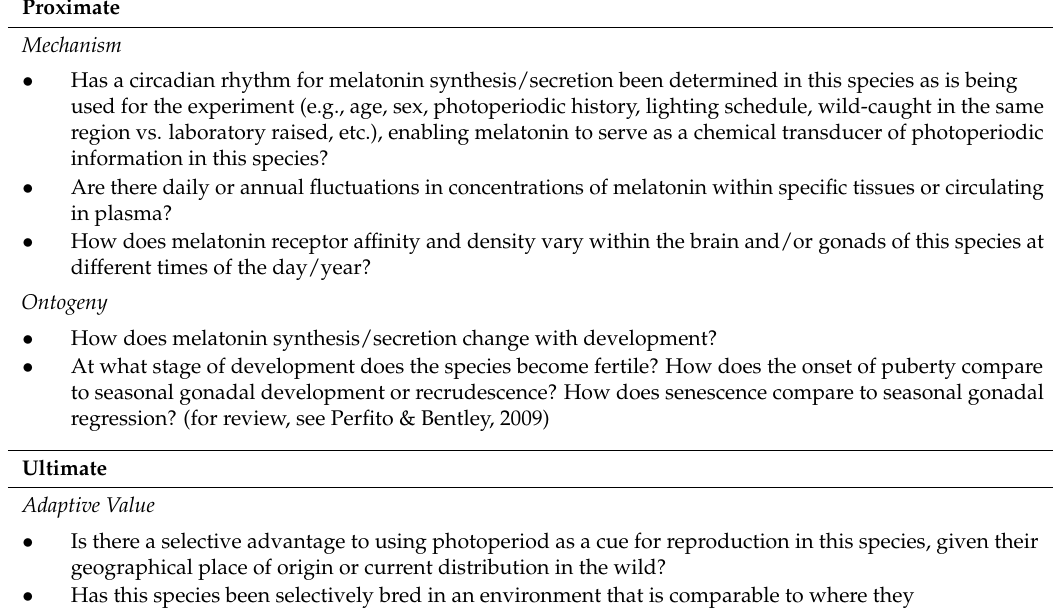
Table 2. Tinbergen’s four questions applied to research in melatonin and seasonal